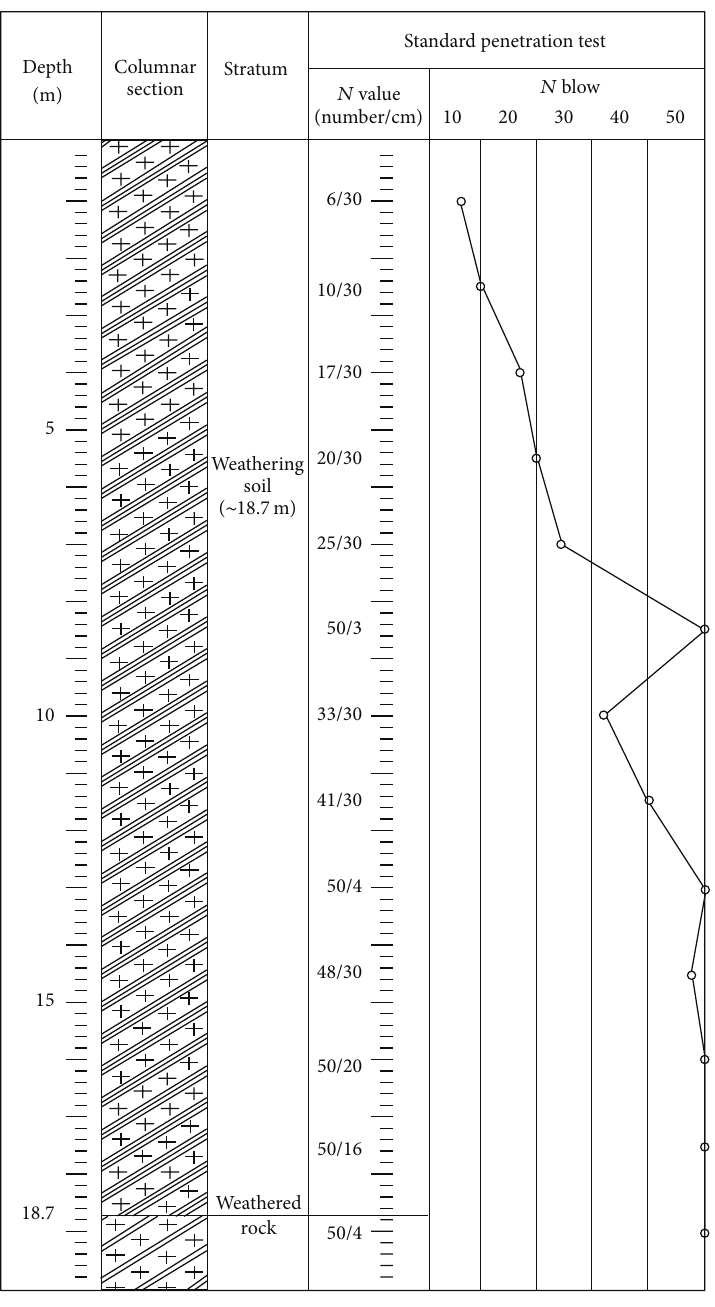
to prevent the evaporation of water, as specified in the ASTM C940 standard